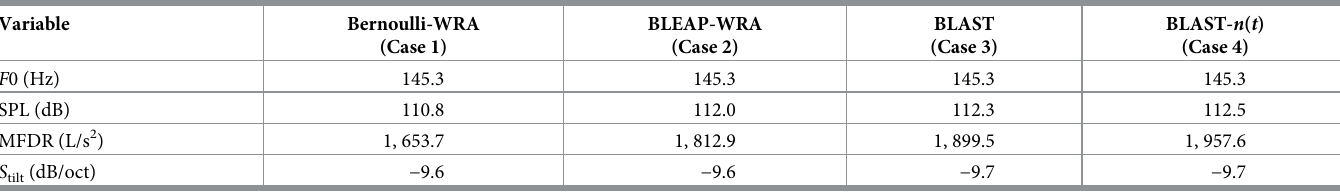
Table 2. Impact of the Bernoulli-WRA flow and acoustic solver (Bernoulli-WRA (Case 1)), BLEAP flow solver and WRA acoustic solver (BLEAP-WRA (Case 2)), BLAST fluid and acoustic solver with constant exponent n (BLAST (Case 3)), and BLAST fluid and acoustic solver with variable exponent n (BLAST- n ( t ) (Case 4)) and their effect on fundamental frequency ( F 0), sound pressure level (SPL), maximum flow declination rate (MFDR) and spectral tilt ( S tilt ) for p Z = 1.0.